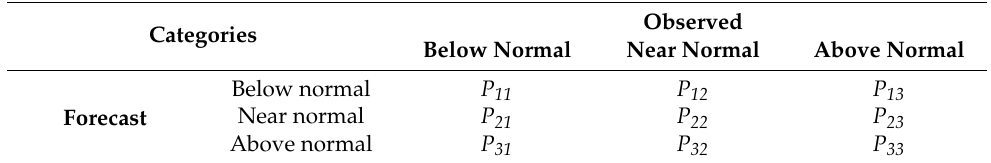
Table 1. Three-category contingency table. P ij is the sample probability, in which i , j are ranged from 1 to 3 and denotes the categories of forecast and observed,